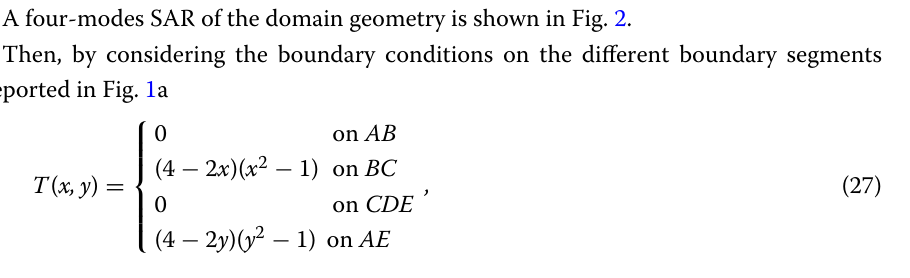
Fig. 2 Four-modes ( i = 1 , 2 , 3 , 4) SAR of the NURBS-based mapping: a M T ( η ) Y 2 i and d M T 2